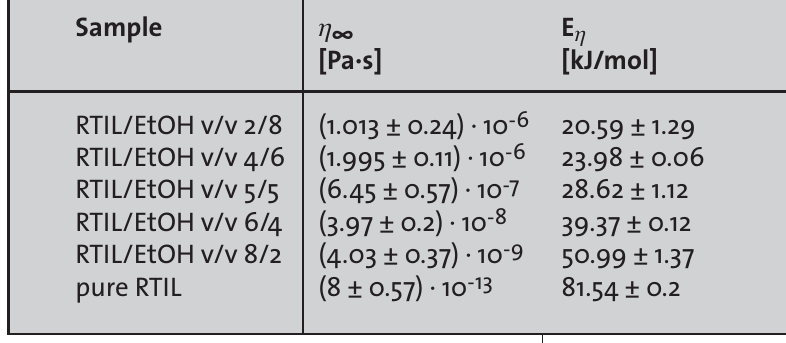
Figure 5 (above): Consistency coefficient plot as a function of tempera- ture for RTIL/EtOH solutions (RTIL content (v/v): 20% ( Ç ), 40 ( Ë ), 50 ( Ú ), 60 ( Ù ), 80 ( Ï ), 100% ( (cid:3) ) in the range of 1 - 25.1 s -1 at 25 - 50°C). Figure 6: Activation energy vs. the volume fraction of RTIL in RTIL/EtOH mixture. Table 1: Activation energy and co- efficients derived from Arrhenius plot for solutions in the range of 1 - 25.1 s -1 at 25 -